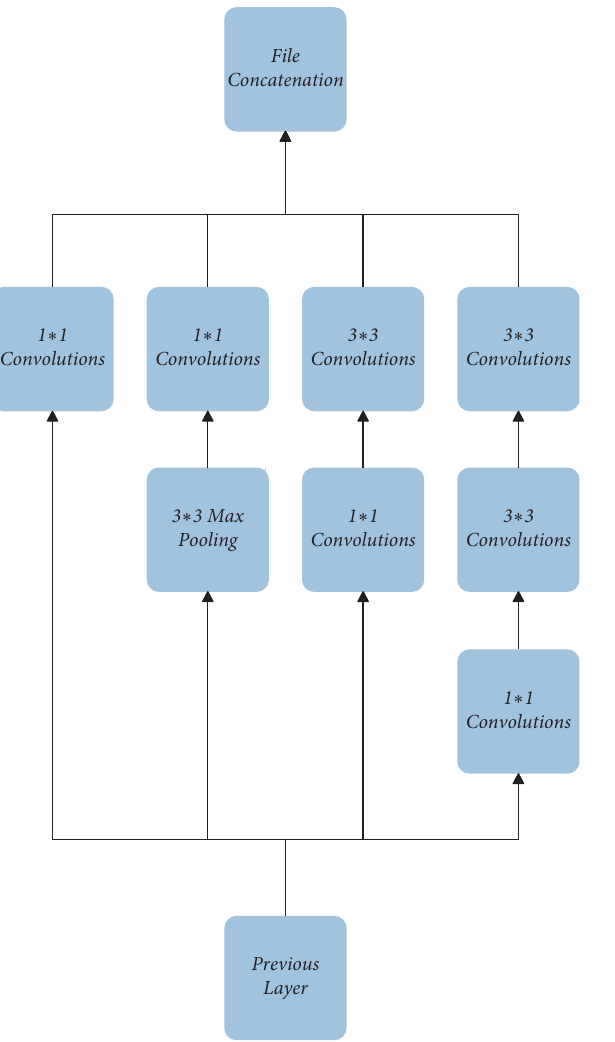
Figure 5: Inception- v 2 module.